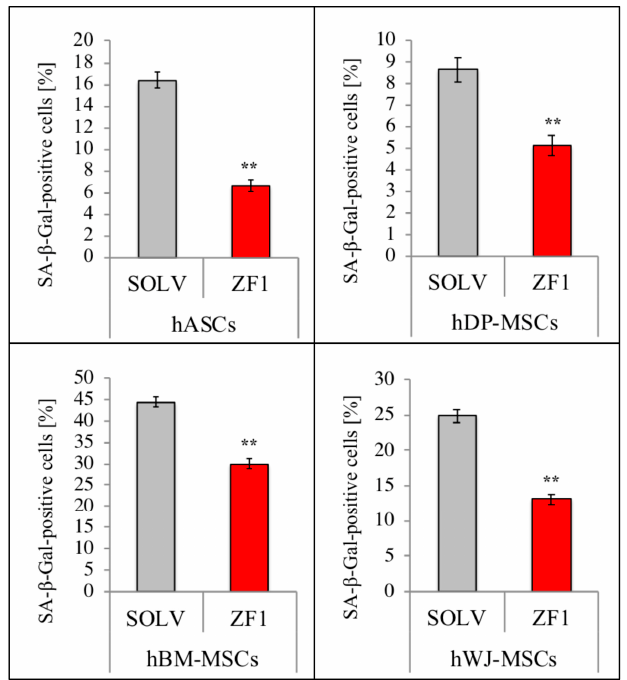
Figure 8. ZF1 counteracts SA β -gal activity in hMSCs. The hMSCs (culture passages 5 th –7 th ) were cultured for 72 h in the presence of 20 μ g/mL ZF1, or a solvent as a control (SOLV). Then, cells were processed for SA β -gal assessment, as described in Figure 4 legend. The experiments with hASCs, hDP-MSCs, hBM-MSCs, and hWJ-MSCs were all performed with cells derived from three subjects. Data represent the percentage of SA β -gal positive cells calculated as the number of positive cells divided by the total number of counted cells multiplied by 100. All ZF1 treated cells were significantly different from the control group (Proportion in % ± SD, n = 3). Statistical significance was evaluated using the Z-test for proportional, ** p < 0.01.